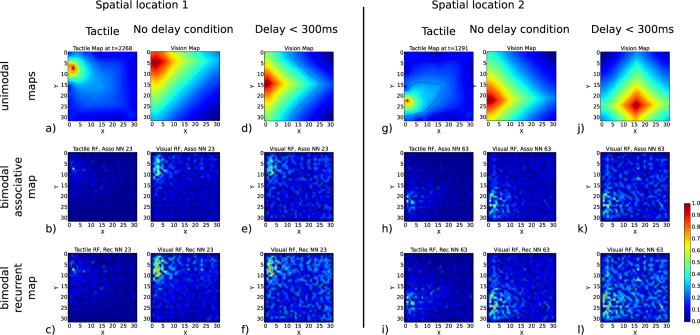
Receptive fields for two different spatial locations of the contact point in the unimodal and bimodal tactile and visual maps.The RFs for the asso. and rec. maps are displayed during the no-delay and delay conditions (300 ms). (a) and (g) correspond to the strict visual and tactile spatial RFs of the unisensory maps taken at one snapshot for two arbitrarily chosen locations. (b) and (h) correspond to the spatial RFs of two bimodal neurons of the asso. map firing the most for the visuo-tactile locations in (a) and (g). (c) and (i) correspond to the spatial RFs of two bimodal neurons of the recurrent map firing the most for the visuo-tactile locations in (a) and (g). Plots (d–f) and (j–l) are the neurons’ activity in the asso. and rec. neurons, when a visual delay of 300 ms is added.